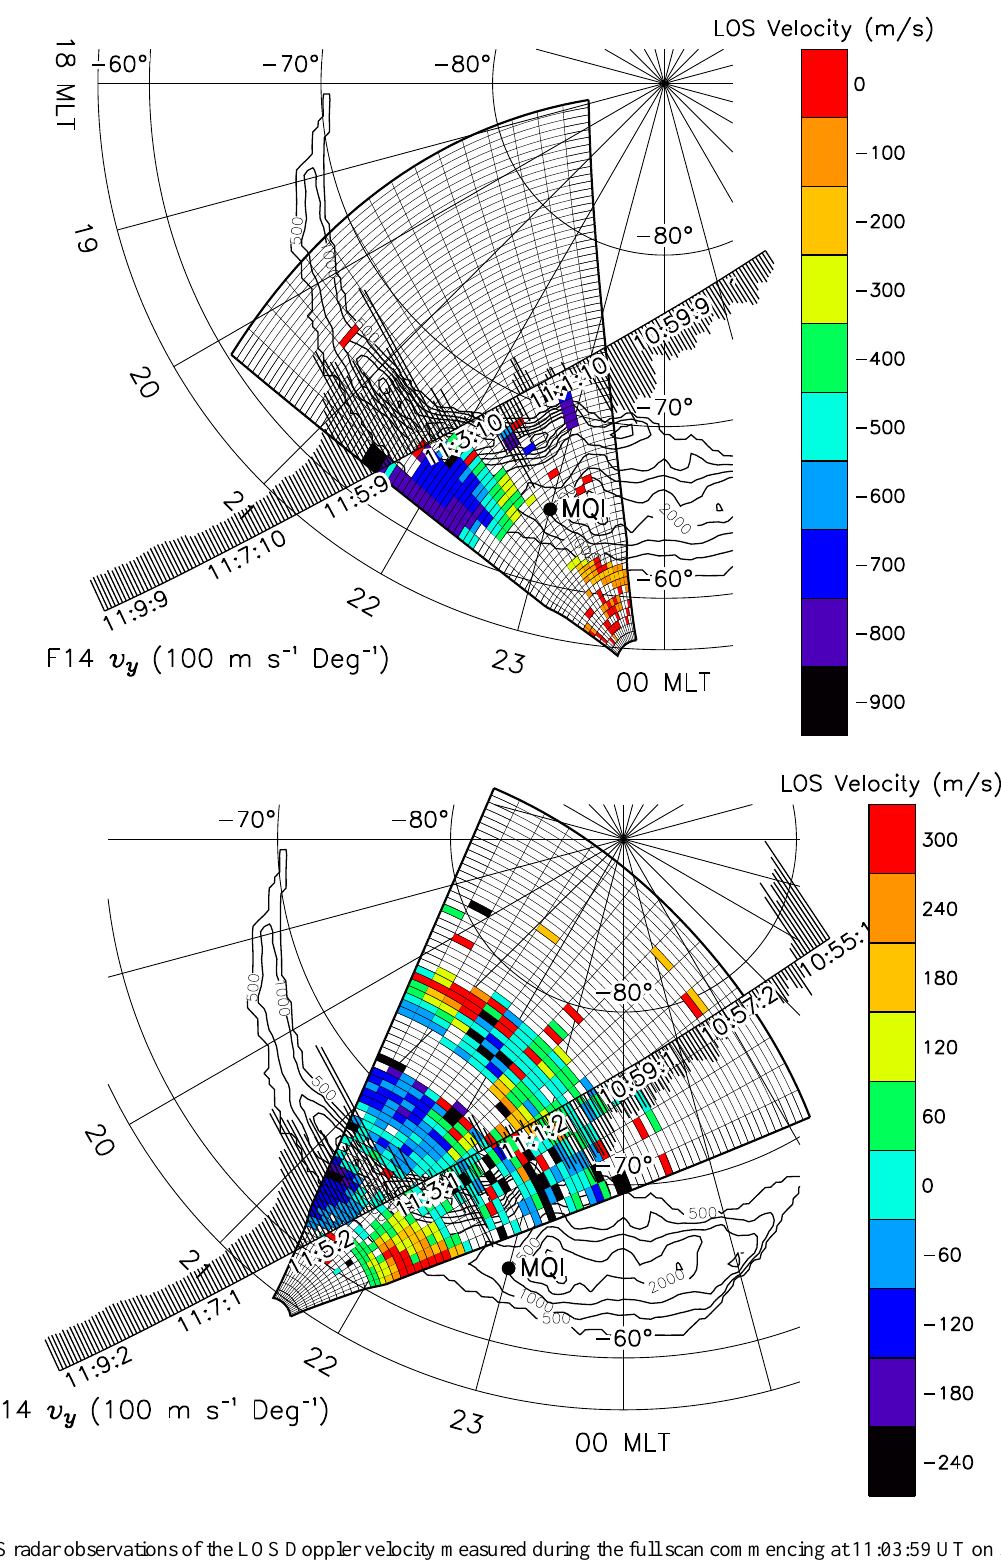
Fig. 5. (a) KGS radar observations of the LOS Doppler velocity measured during the full scan commencing at 11:03:59 UT on 30 November 2002. DMSP F14 measurements of ion drift velocity transverse to the satellite trajectory have been superimposed using a scale of 100ms − 1 ◦ 3 − 1 . They were mapped to the Northern Hemisphere simply by inverting the magnetic latitudes. (b) TIGER radar observations of the